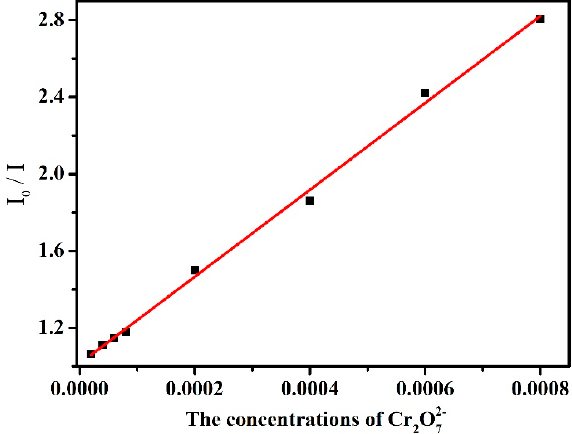
Figure 6. ( a ) The emission spectra of compound 2 dispersed in aqueous with different concentrations of Cr 2 O 72 − ; and ( b ) dependence of the quenching efficiency on the concentration of Cr 2 O 72 − .